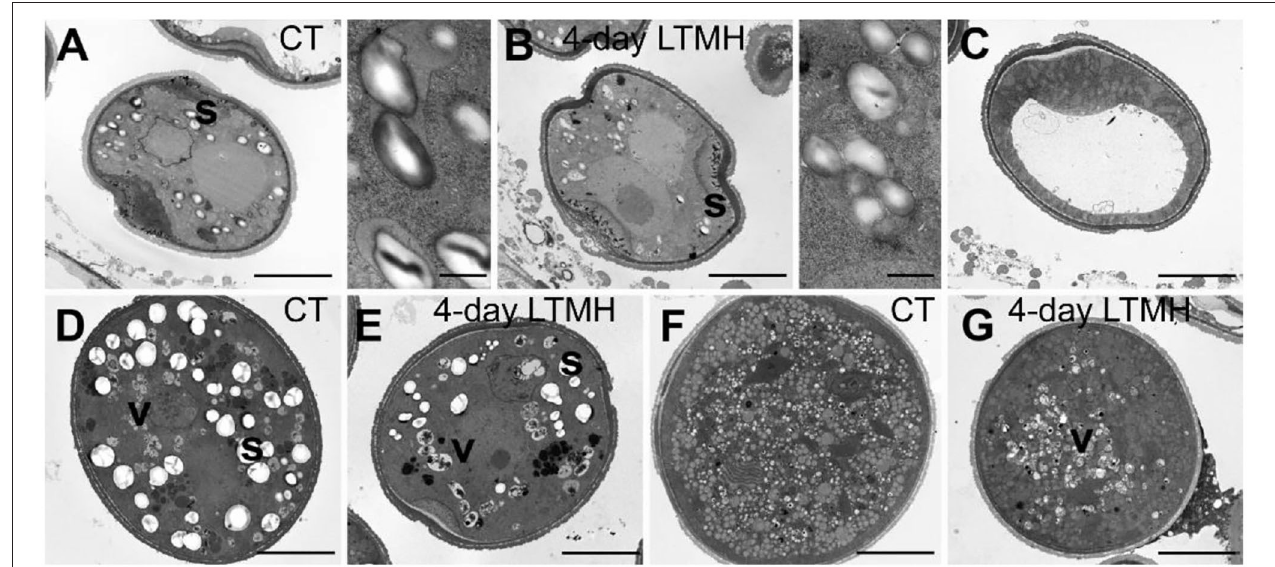
FIGURE 4 | Comparison of pollen ultrastructure between control and 4-day long-term mild heat treatment by electron microscopy. (A,B) Early bicellular from control temperature (CT) (A) and 4-day long-term mild heat treatment (LTMH) (B) , with close-ups of starch granules. (C) Second vacuolisation stage, characterized by absence of starch granules, from LTMH. No apparent differences were found relevant to control. (D,E) Mature pollen stage from control (D) and LTMH (E) . (F,G) Pollen at anthesis from control (F) and LTMH (G) . s, starch granule (large, white spherically shaped); v, vacuole (grayish, more or less spherically shaped, with dark debris visible inside). Bar = 5 µ